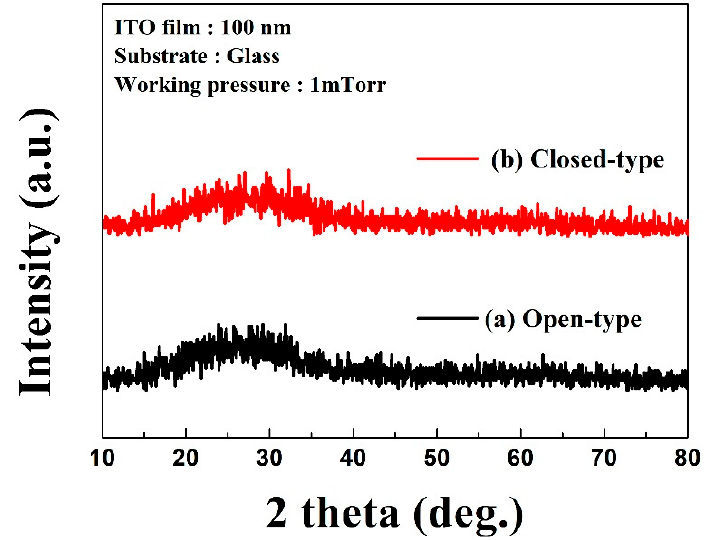
Figure 7. X-ray di ff raction patterns of prepared films at a working pressure of 1 mTorr without substrate Figure 7. X-ray diffraction patterns of prepared films at a working pressure of 1 mTorr without heating. (a) Open-type FTS (OFTS) and (b) Closed-type FTS substrate heating. (a) Open-type FTS (OFTS) and (b) Closed-type FTS (CFTS).